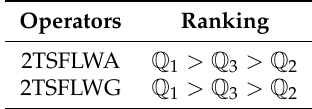
Table 4. Ranking of the alternatives.